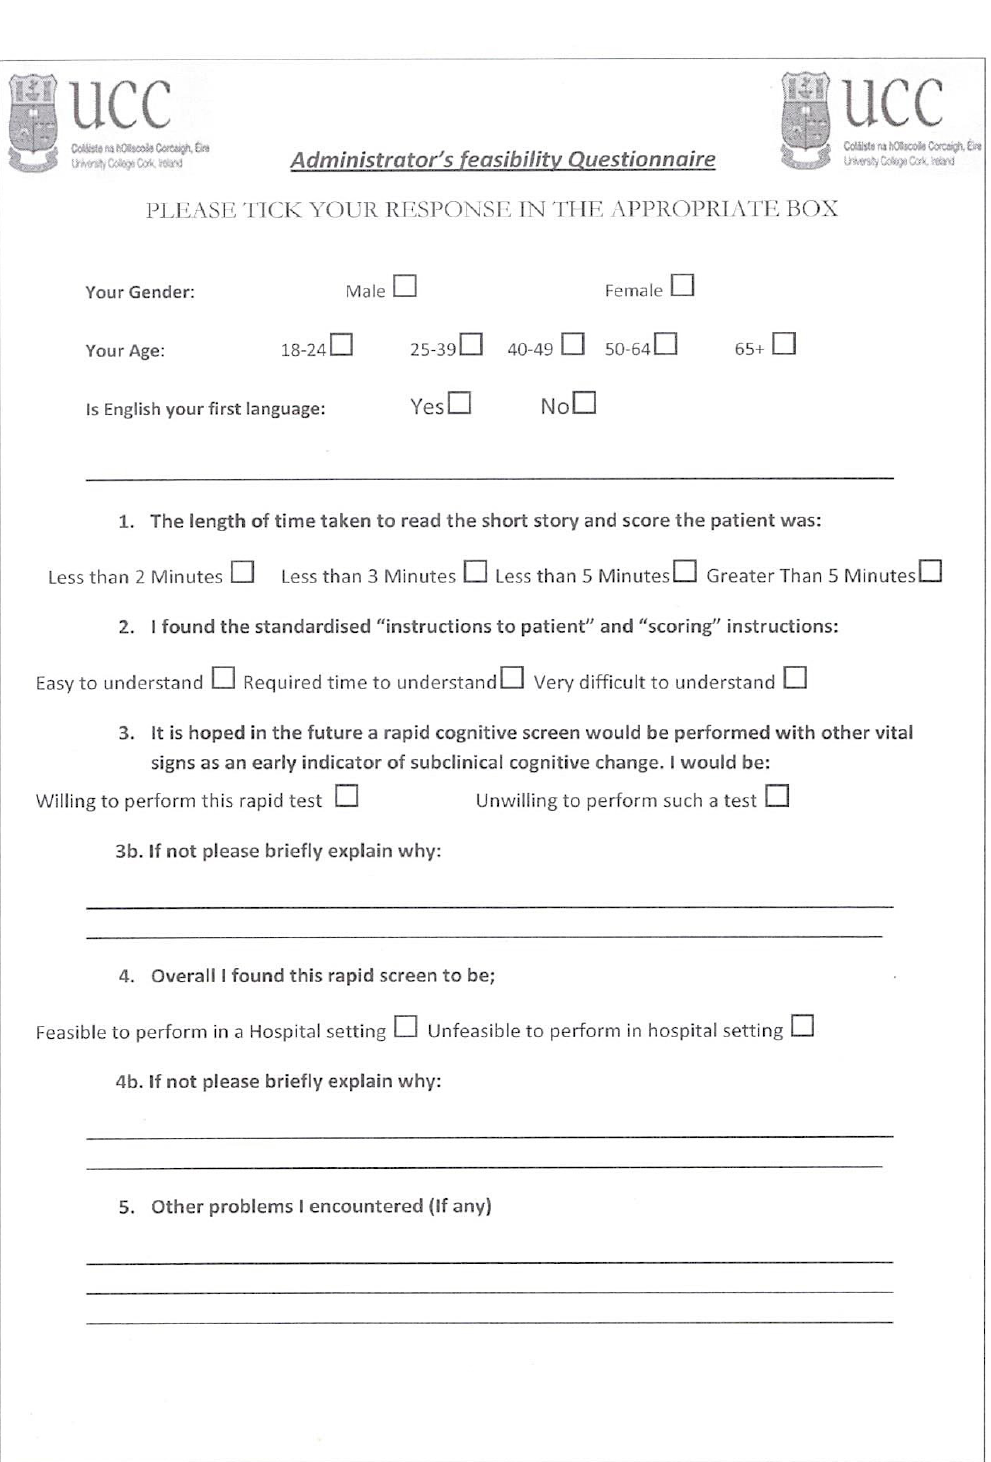
Figure A3. Feasibility questionnaire.